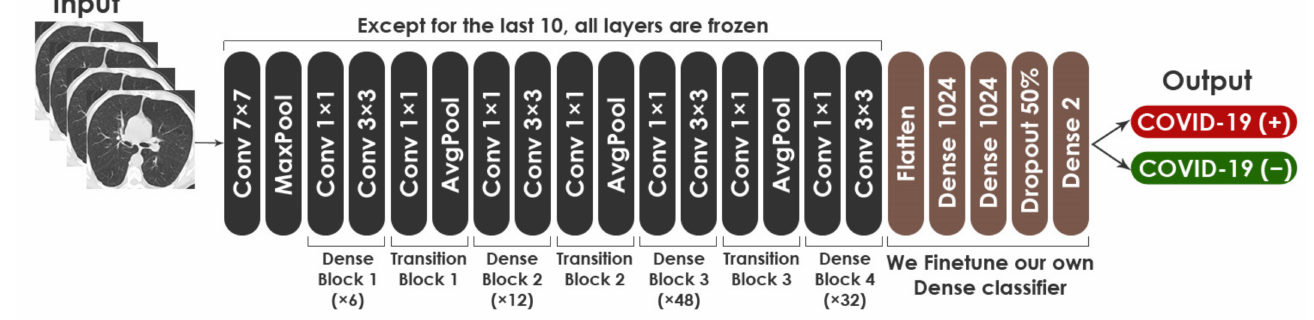
Figure 13. Architecture of modified